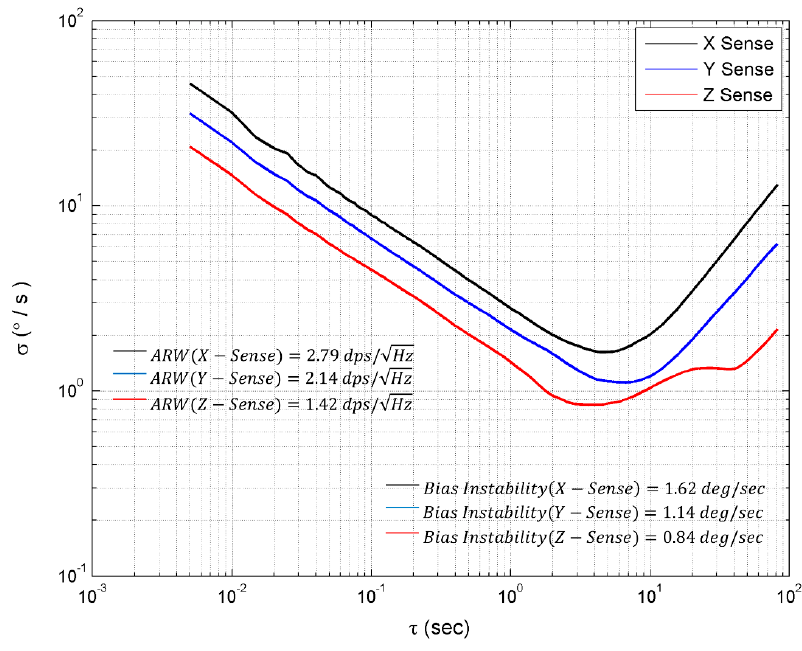
Figure 10. Root Allan variance plot of single drive multi ‐ axis gyroscope.